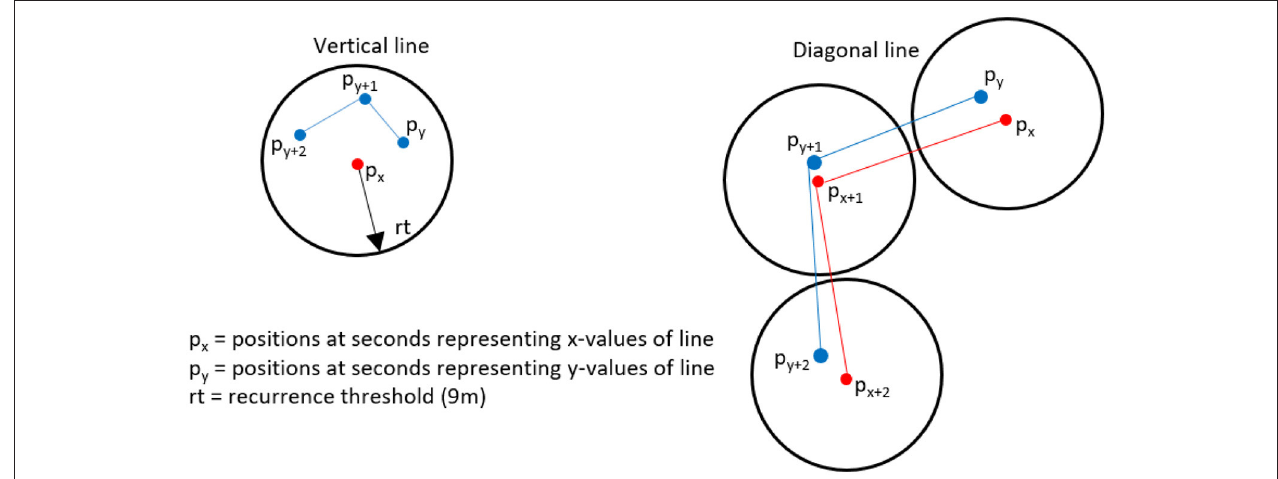
FIGURE 1 | Illustration of trajectories resulting in vertical and diagonal lines; a vertical line is created when the process after time t = y stays in the rt-vicinity of a point p x , i.e., for t = y + 1, y + 2,…; a diagonal line is created when the process unfolds within the rt-vicinity after time t = x and t = y, i.e., stays below rt at t = x + 1, t = y + 1; t = x + 2, t = y + 2;....